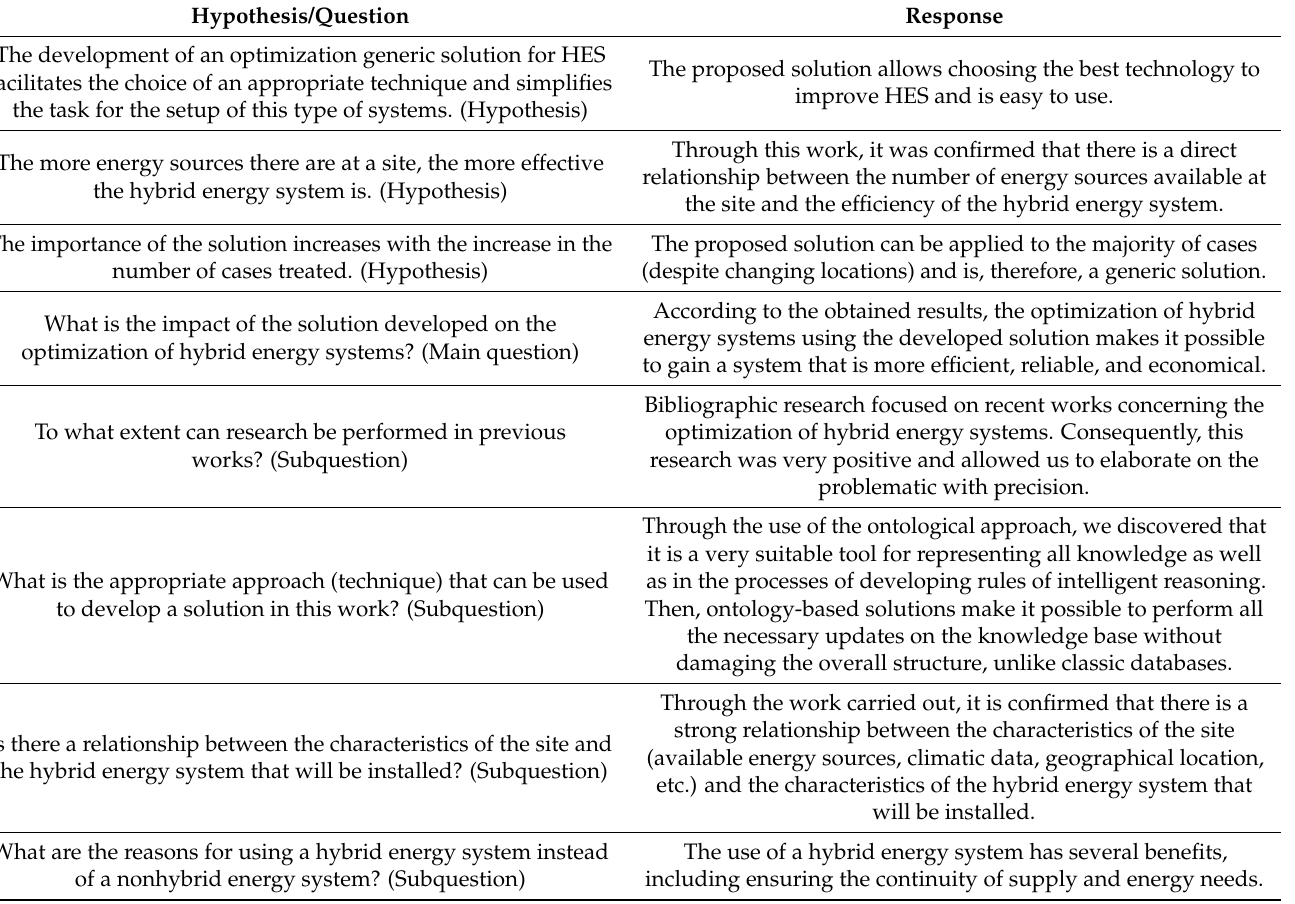
Table 8. Samples of evaluation of the proposed